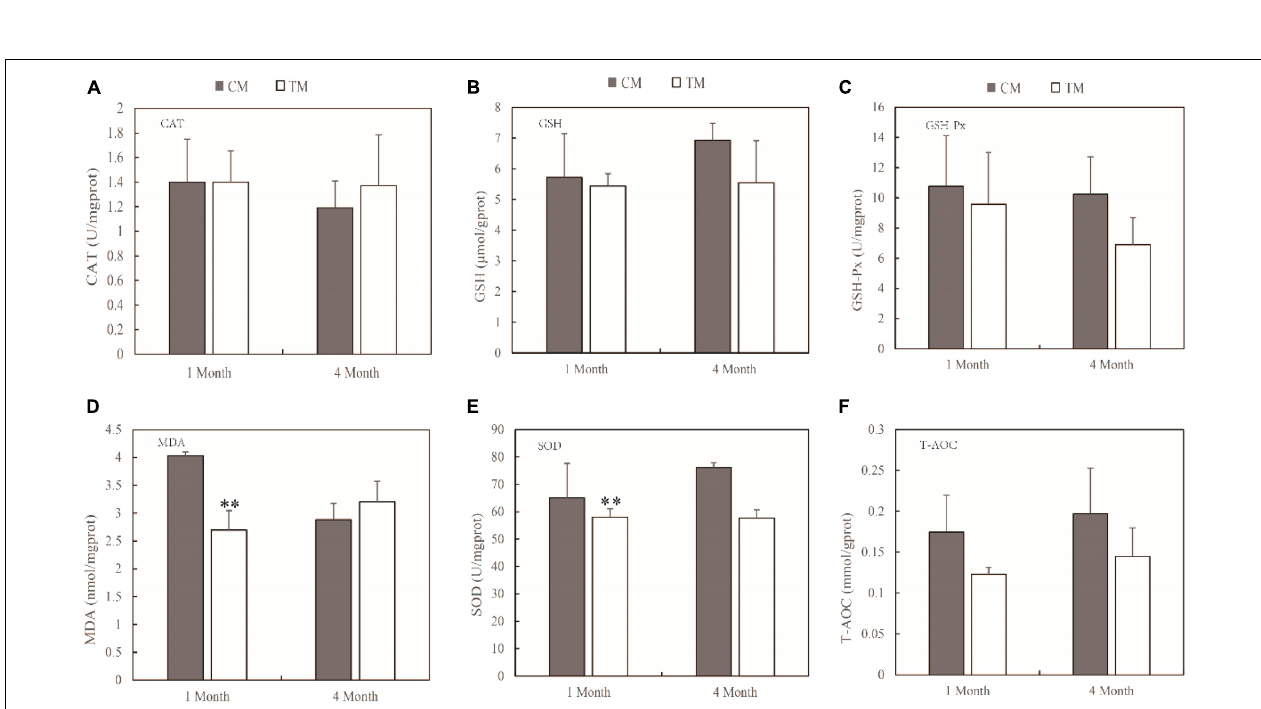
FIGURE 2 | Antioxidant responses of adult zebrafish exposure to TWTP effluents (1 and 4 months) in the muscle tissue. Catalase (CAT) (A) , glutathione (GSH) (B) , Glutathione peroxidase (GSH-Px) (C) , malondialdehyde (MDA) (D) , superoxide dismutase (SOD) (E) , and total antioxidant capacity (T-AOC) (F) . Values presented are mean ± SD ( n = 24 fish/treatment). ∗∗ Stands for extremely significant differences among treatments compared with the control ( P < 0.01).